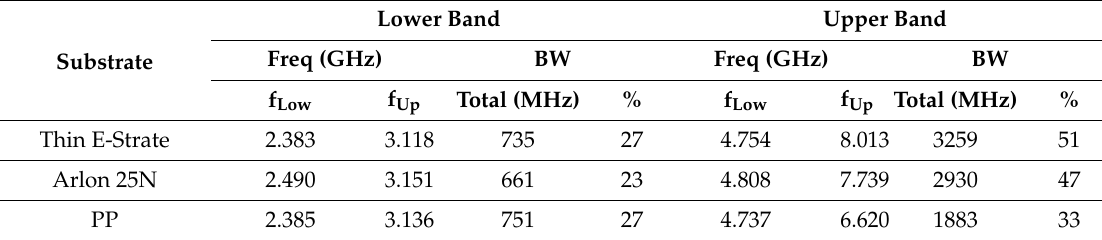
Frequency bands and bandwidths of the CPW-fed monopole antenna for di ff erent dielectric